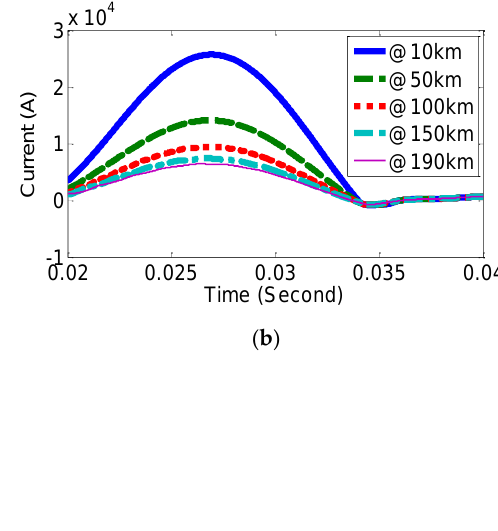
R (with R = (1 Ω, 10 Ω, 25 Ω, 35 Ω, 50 Ω), inception angle = 0° and fault location = 190 Km R (with R = (1 Ω , 10 Ω , 25 Ω , 35 Ω , 50 Ω ), inception angle = 0 ◦ and fault location = 190 Km reduced from 6.4 kA to 4.1 kA, or by about 36%. Figure 4d show the sending end signals reduced from 6.4 kA to 4.1 kA, or by about 36%. Figure 4d show the sending end signals under different inception angle (with fault resistance = 10 Ω, Inception A ngle Ɵ = (0° to under different inception angle (with fault resistance = 10 Ω , Inception Angle θ = (0 ◦ to 180°), and fault location = 190 km for the one-phase (a) to ground fault. Moreover, the 180 ◦ ), and fault location = 190 km for the one-phase (a) to ground fault. Moreover, the beginning current amplitude in the case of fault at 0°, and 45° is much more than 90°, 135°, beginning current amplitude in the case of fault at 0 ◦ , and 45 ◦ is much more than 90 ◦ , 135 ◦ , and 180°. beginning current amplitude in the case of fault at 0°, and 45° is much more than 90°, 135°, and 180 ◦ .